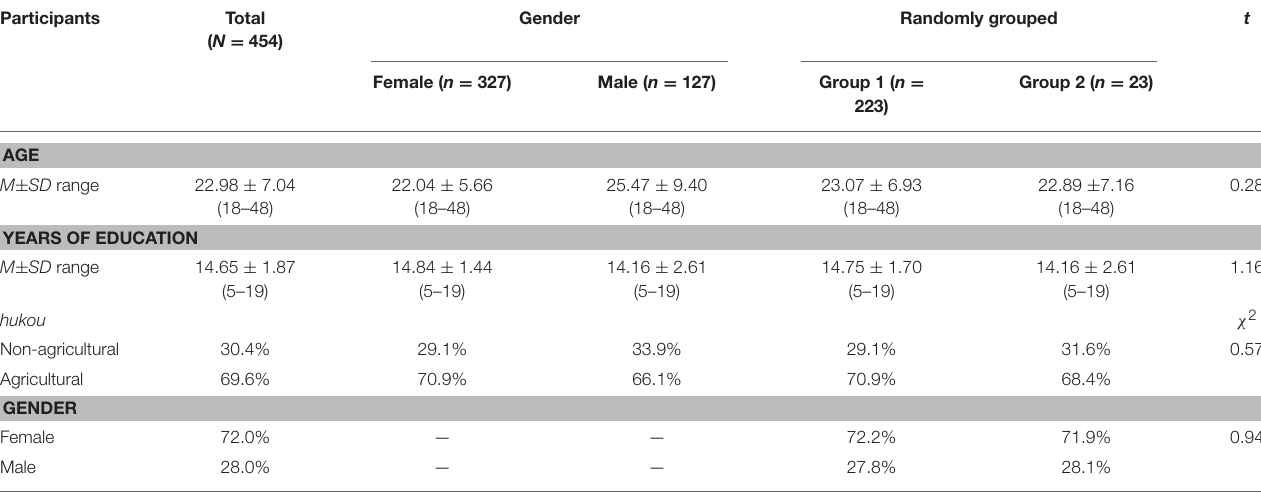
TABLE 1 | Descriptive statistics of participants’ background variables.